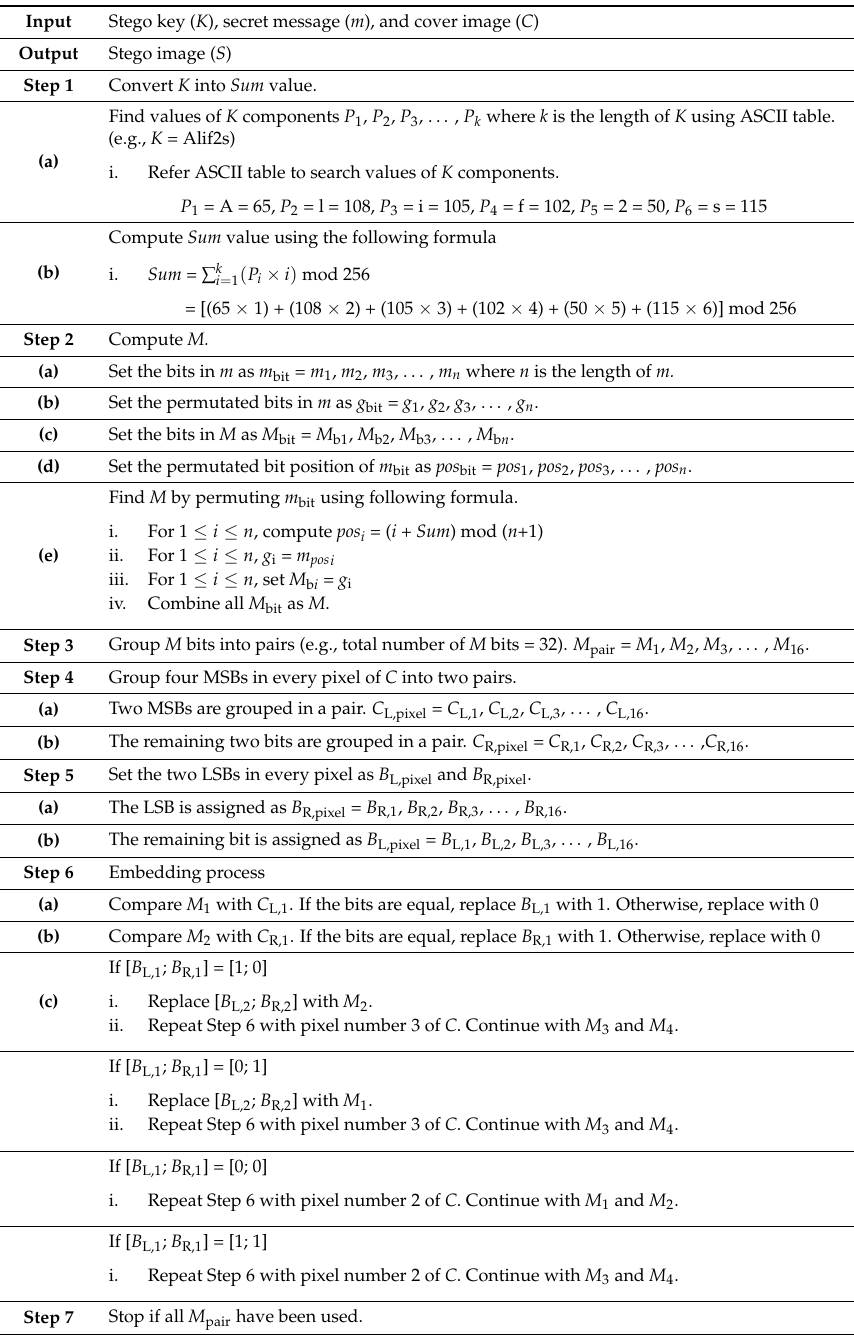
Table 2. The proposed embedding